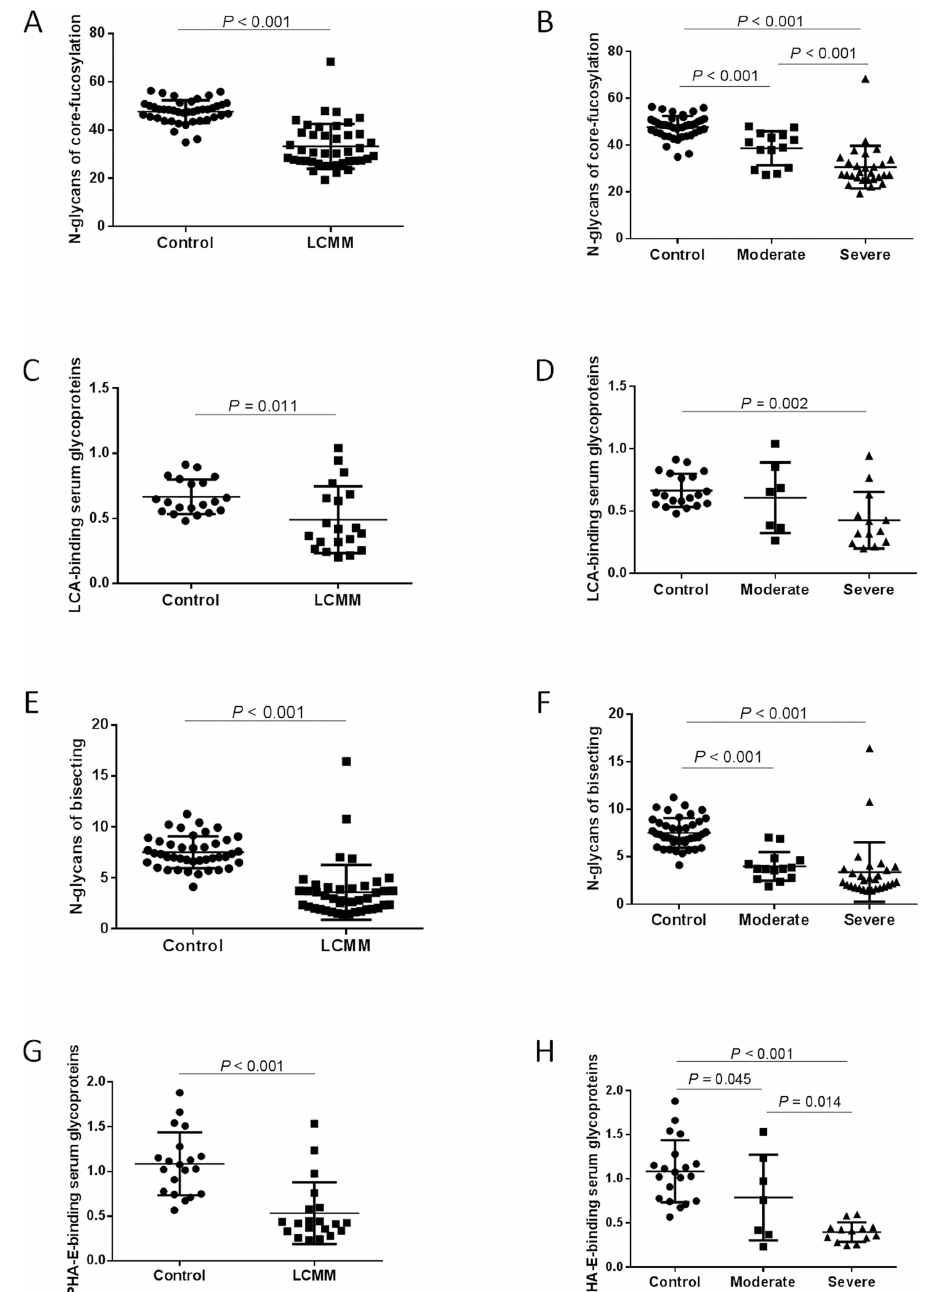
Fig 4. The abundance of core fucosylation and bisecting modification in N-glycan and glycoprotein levels. The abundance of core fucosylation and bisecting modification in N-glycan and glycoprotein levels were illustrated using DSA-FACE and serum lectin blot. (A) and (B): The abundance of total core fucosylation residues (the sum of Peak1, 2, 3, 4, 6, 7 and Peak10) from DSA-FACE decreased in LCMM patients (n = 42) than that in healthy controls (n = 42), and decreased according to the severity of the disease [moderate LCMM (n = 14) and severe LCMM (n = 28)]. (C) and (D): LCA binding core-fucosylated glycoprotein level detected by serum lectin blot was decreased in LCMM patients (n = 20) than that in healthy controls (n = 20). The level of serum core-fucosylated glycoprotein was significantly lower in severe LCMM (n = 13) but not in moderate LCMM (n = 7). The vertical axis indicates the ratio of fluorescence intensity of fucosylated proteins to total proteins stained by coomassie blue (CBB). (E) and (F): The abundance of total bisecting residues (the sum of Peak2 and Peak7) from DSA-FACE deceased in LCMM patients than that in healthy controls,